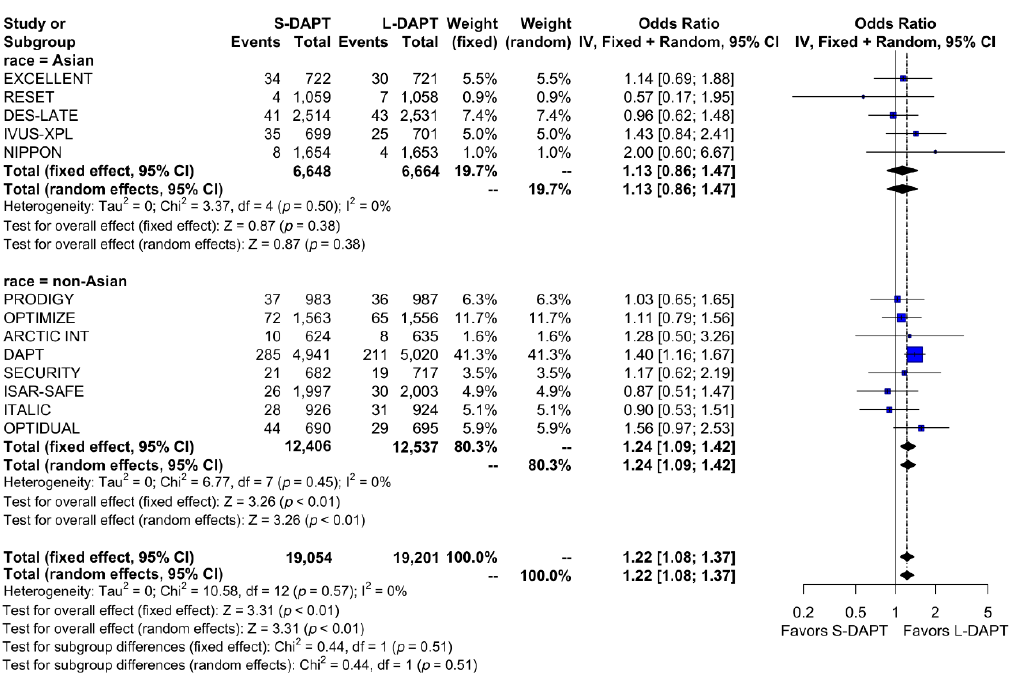
Figure 3. Ischemic outcomes in randomized clinical trials. S-DAPT, short duration dual